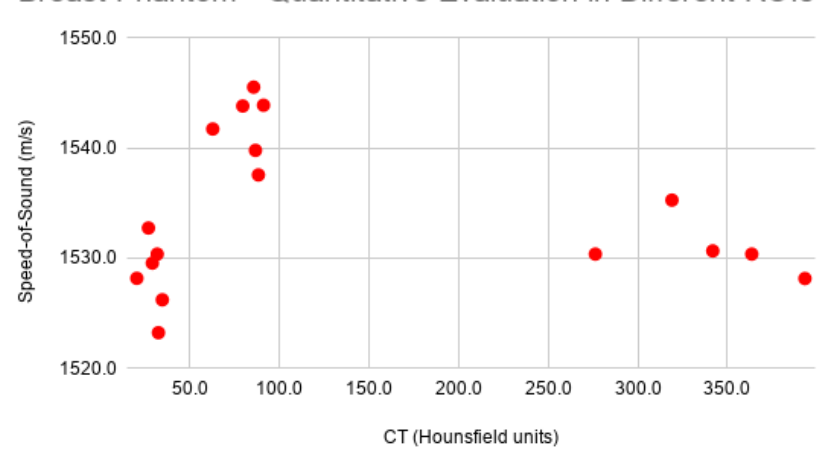
Figure 8. Values of speed of sound of different obtained regions from the FWI USCT images, and their corresponding Hounsfield units from